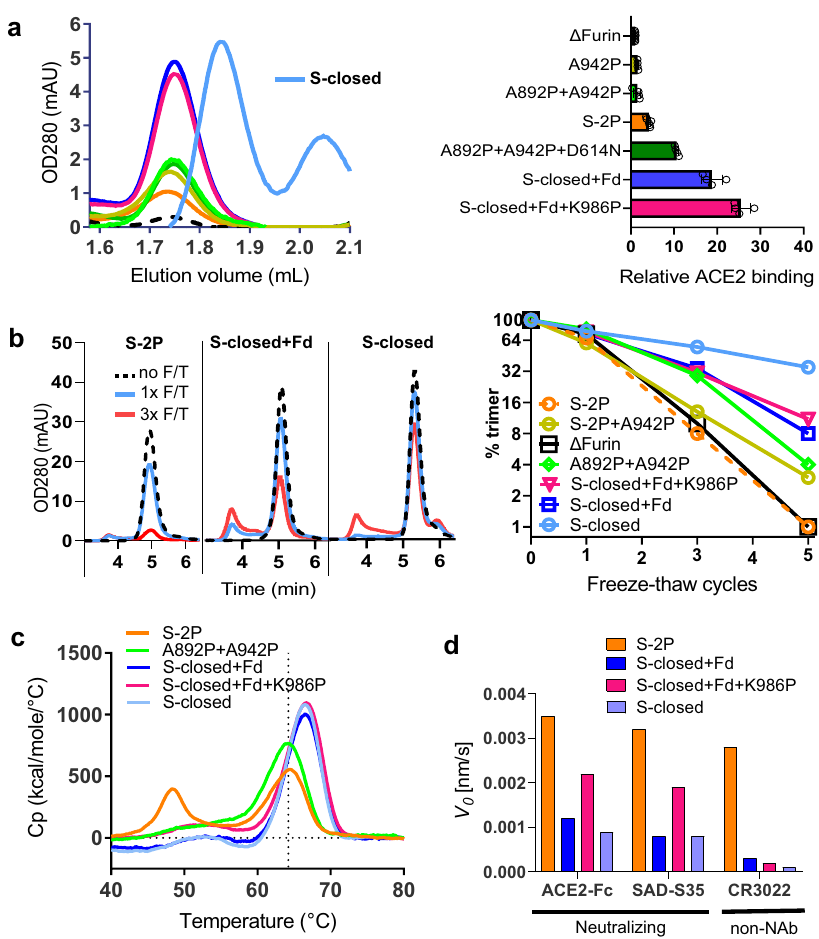
Fig. 2 Characterization of SARS-CoV-2 S mutants containing combinations of stabilizing mutations. a Analysis of cell culture supernatant after transfection using analytical SEC using an SRT-10C SEC-500 15 cm column (left panel) and ACE2-Fc binding based on AlphaLISA (right panel) of Δ Furin S with combinations of stabilizing mutations. Data are represented as mean + SD of n = 4 biologically independent samples in one experiment. b Freeze- thaw stability of puri fi ed uncleaved S trimers with indicated stabilizing mutations as measured by analytical SEC. Chromatograms are shown for non-frozen (dashed black line), 1×frozen (light blue line), and 3×frozen (red line). c Temperature stability of puri fi ed combined S trimer variants by DSC. d Binding of SAD-S35, ACE2, and CR3022 to puri fi ed combined S trimer variants measured with BioLayer Interferometry, showing the initial slope V 0 at the start of binding. Source data are provided as a Source Data fi